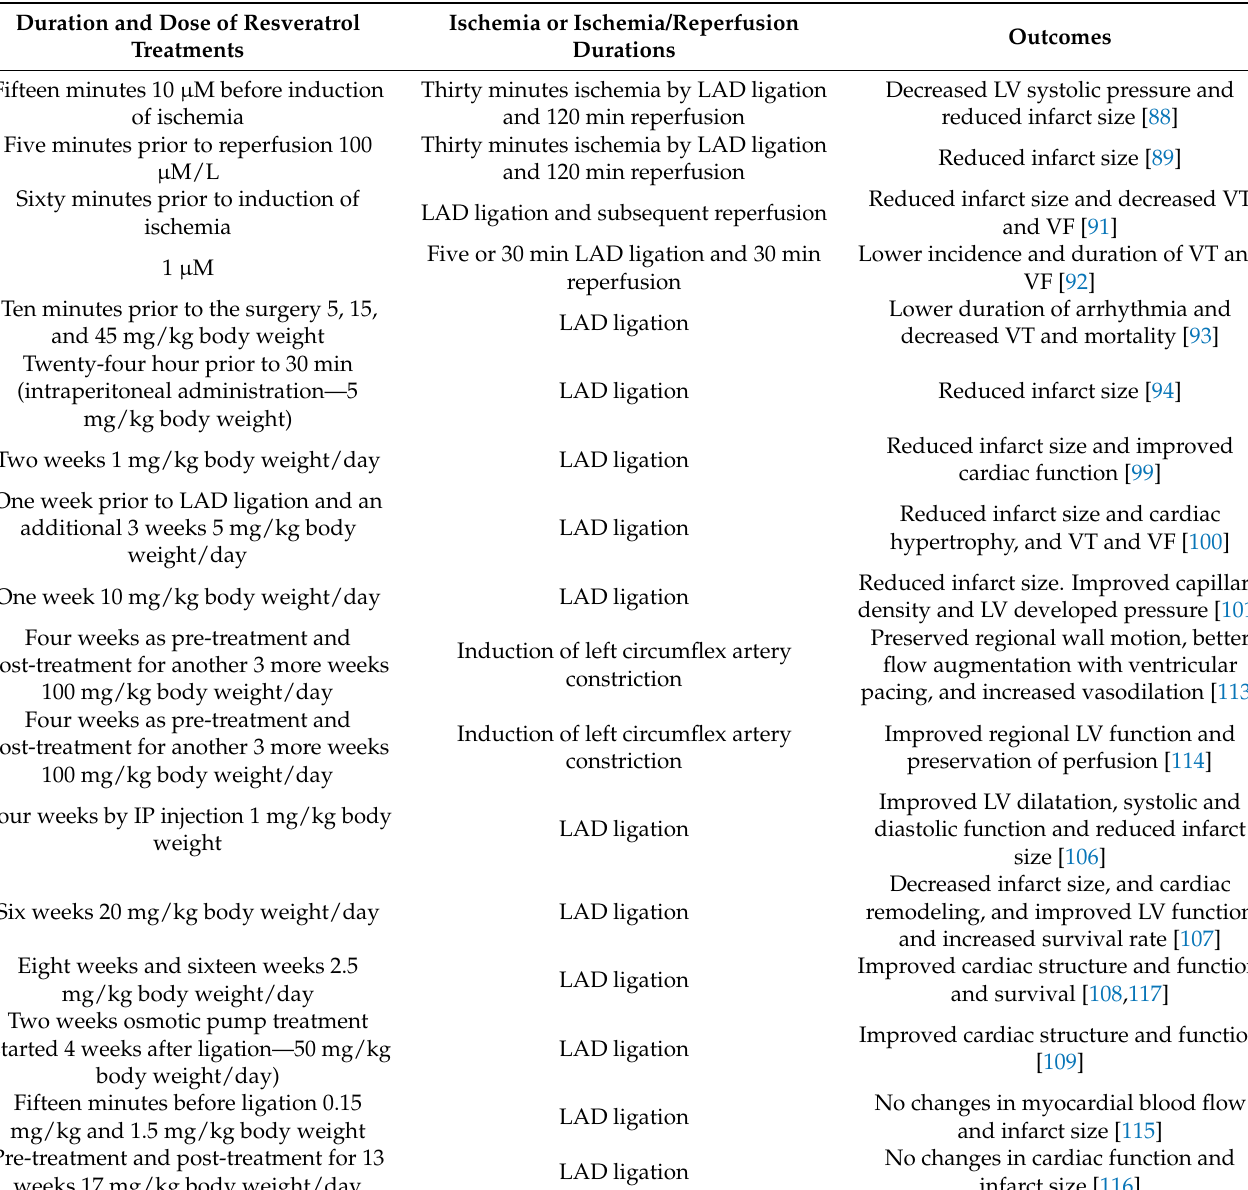
Table 2. In vivo evidence of resveratrol mediated cardioprotection in ischemia and